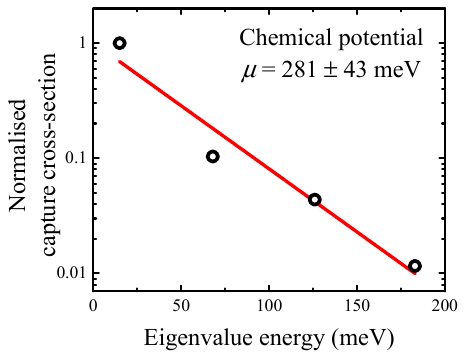
Figure 3. Normalised capture cross-section dependence on energy eigenvalues for heterostructure with 𝑥 = 0.32% , 𝑦 = 13.3% , and 𝑑 = 16.6 nm (shown in Figure 2) with the quantum well depth of 289 meV as estimated by energy band offset reports.